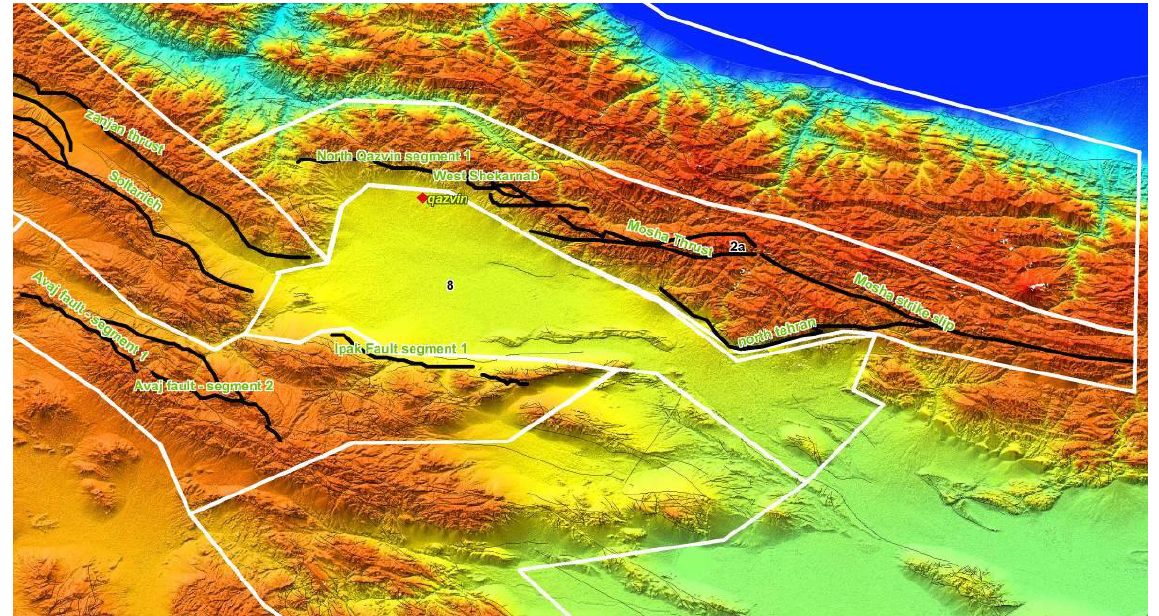
Figure 9. The positions of some important faults around Qazvin (Azizi,